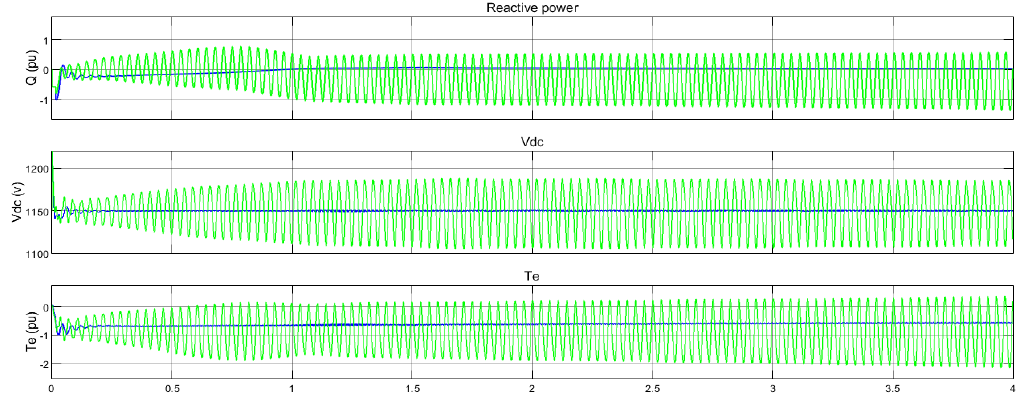
Figure 13. Damping of capacitor voltage, reactive power, and electrical torque in k = 75%, v = 7 m/s and time delay 500ms with the proposed FLWADC and without control.